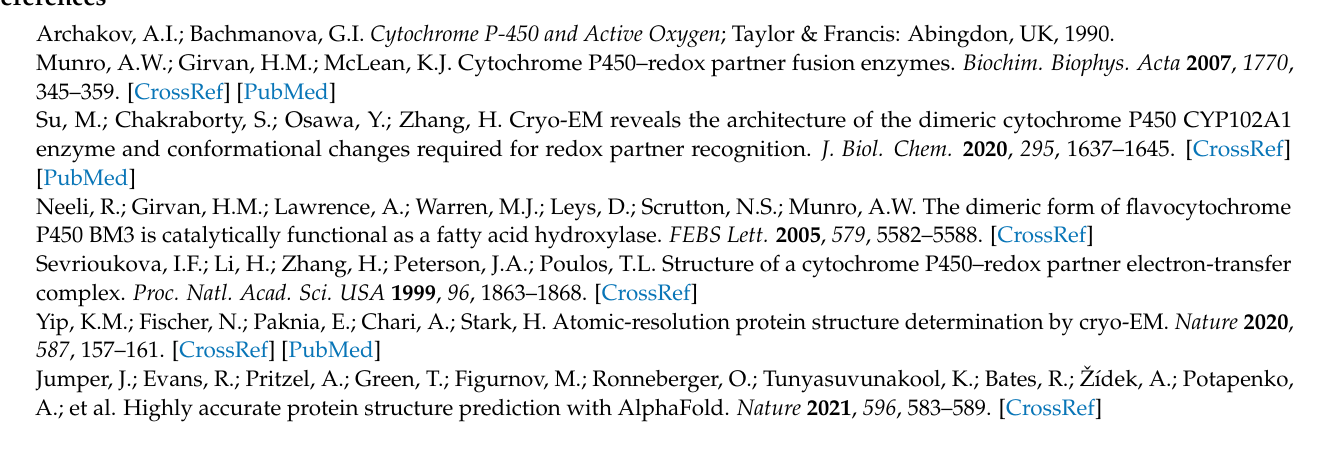
Figure S2: Alignment of experimental structures of individual domains to predicted CYP102A1/A83F structure; Figure S3: Spatial structure of CYP102A1/A83I homodimer; Figure S4: Spatial structure of CYP102A1/A83F homodimer; Table S1: Minimal distances between atoms of prosthetic groups (Å) and controlling constants (s − 1 ). k cat values are from literature data. The predicted structures of all proteins are presented in Protein Data Bank (.pdb) file